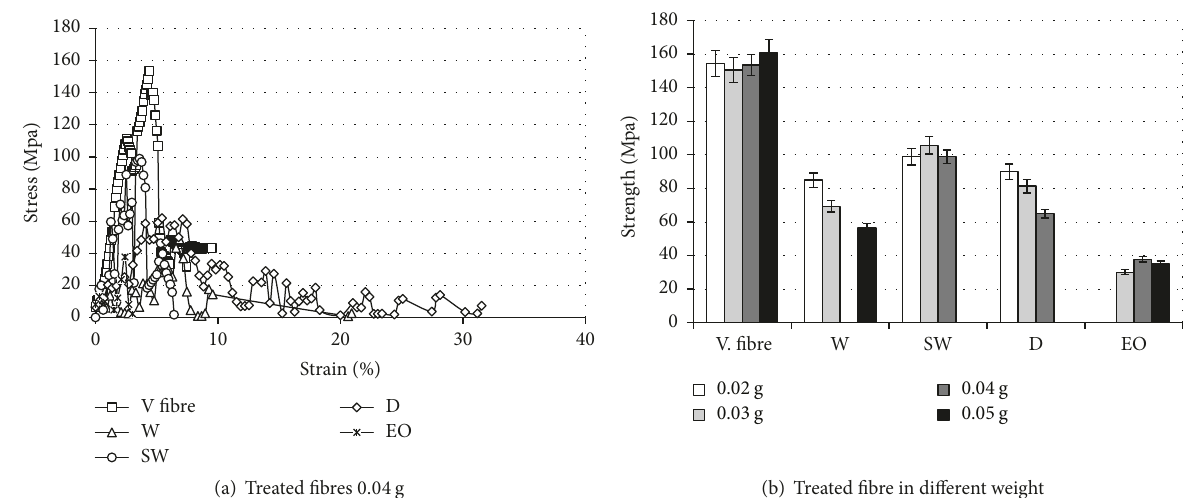
Figure 3: Tensile properties of treated fibres and aging in different solutions.